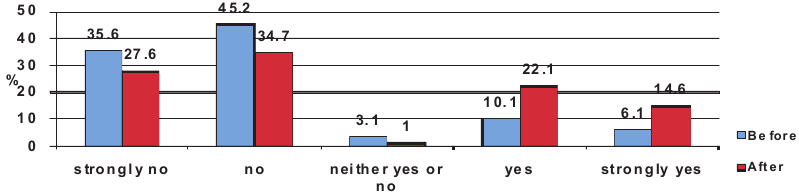
Figure 1: Proportion of uncircumcised males accepting VMMC before and after male circumcision HIV link is